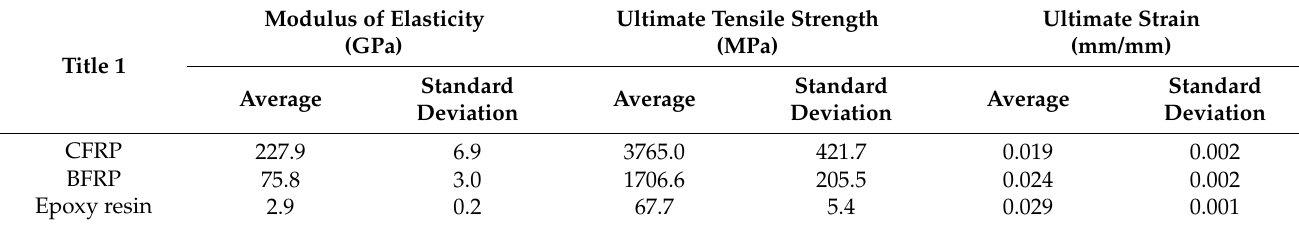
Table 1. Properties of FRP and epoxy resins.